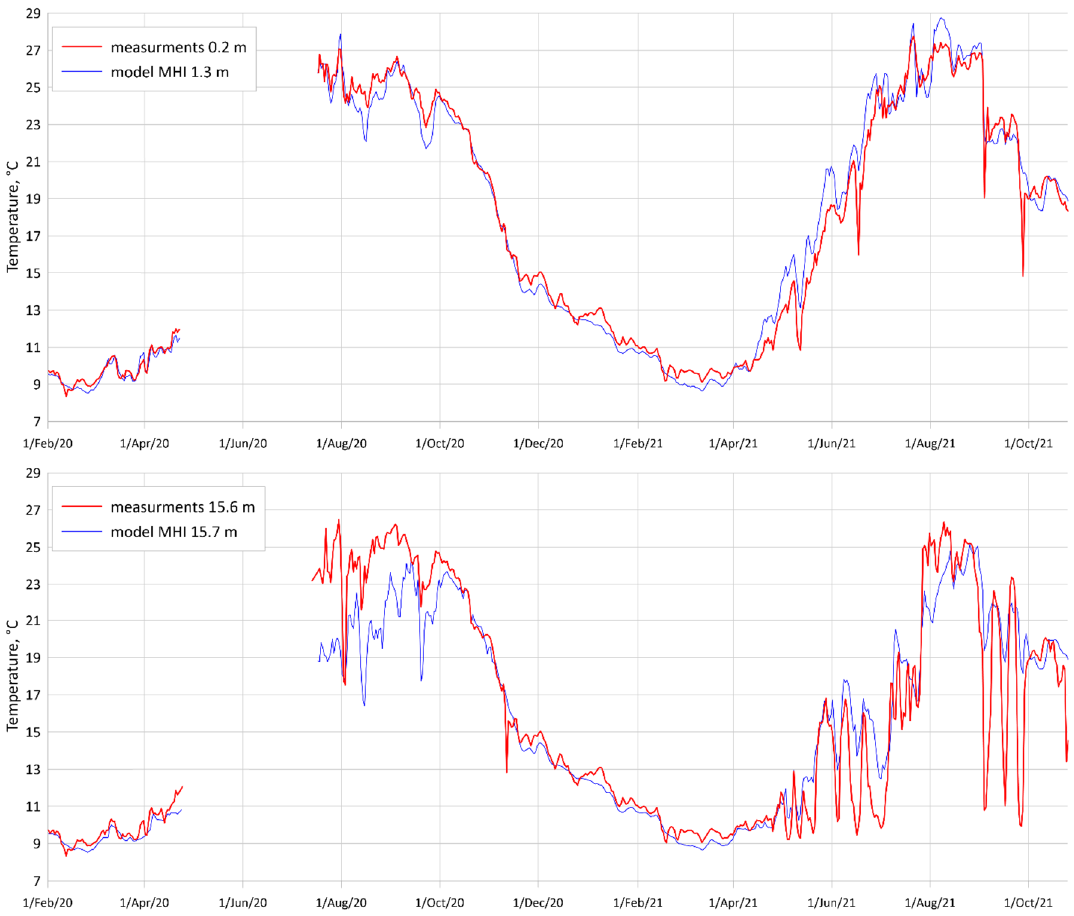
Figure 16. Water temperature at the surface and 15 m according to the measurements (red line) and MHI model data (blue line) from 1 February 2020 to 25 October 2021. The temperature at 15.6 m dropped from 21 to 10 °C in September 2021 according to the measurements. The MHI model reproduced these oscillations well in phase, but their